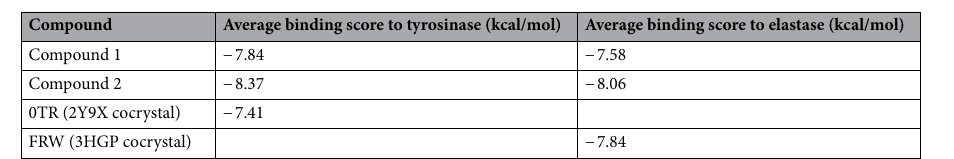
Table 2. Binding score of compounds to tyrosinase (PDBID 2Y9X) and elastase (PDBID 3HGP), evaluated using DockThor.